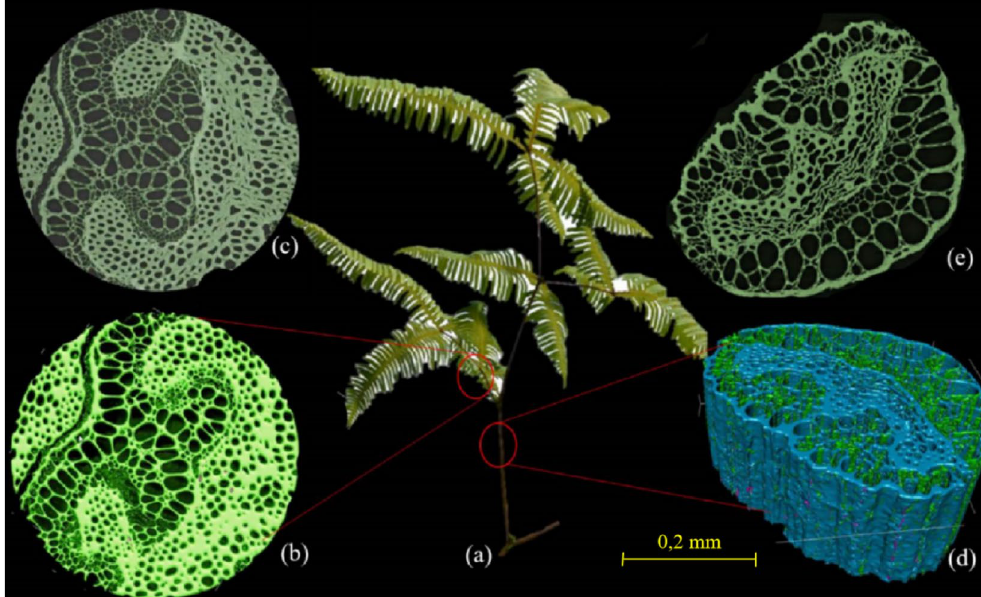
Figure 1. Schematic description of ( a ) D. linearis biomass and tomography 3D images showing different parts: ( b , c ) petiole and ( d , e ) stem.